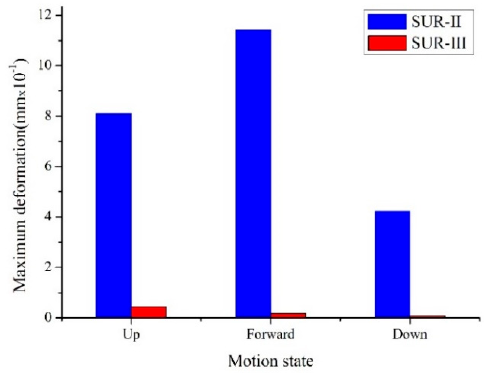
Figure 7. Deformation comparison of SURII and SURIII.